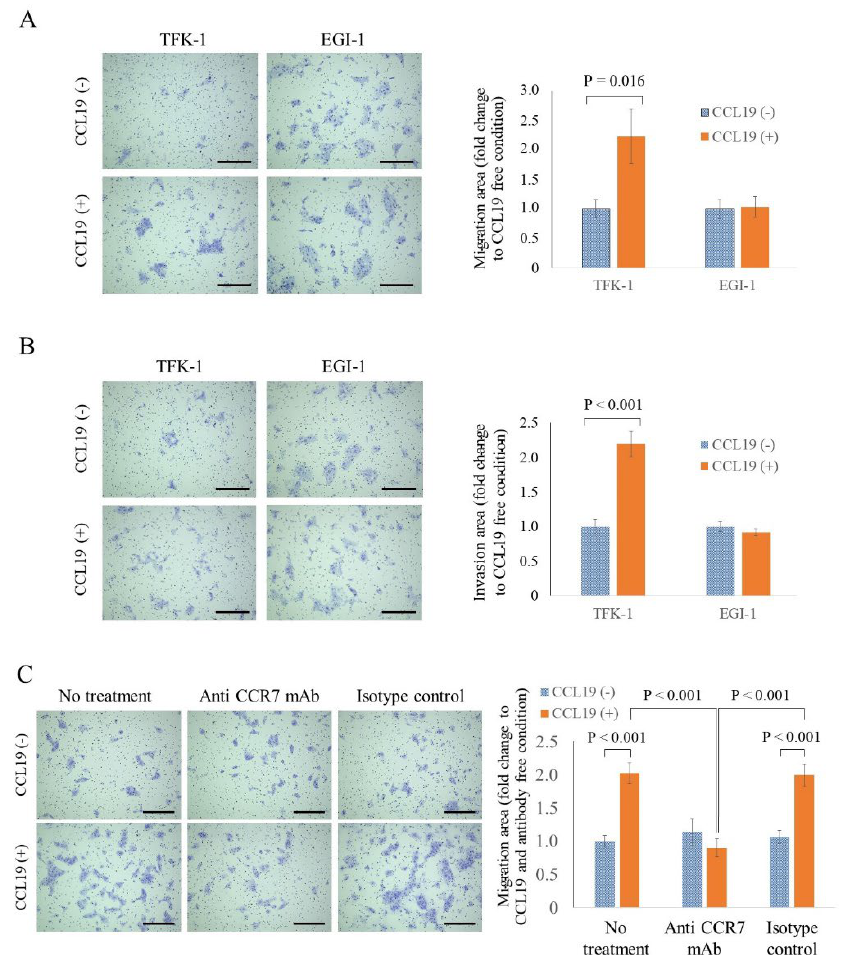
Figure 5. CCR7-dependent CCL19 promoted migration and invasion in cells. ( A ) The migration assay, used to determine the vertical migration ability for 48 h, showed that migration was significantly enhanced by treatment with CCL19 (100 ng/mL) in TFK-1 cells only ( p = 0.016, one-way ANOVA). ( B ) The invasion assay, used to determine the invasion ability for 48 h, showed that invasion was significantly enhanced by treatment with CCL19 (100 ng/mL) in TFK-1 cells only ( p < 0.001, one-way ANOVA). ( C ) A migration assay performed after preincubation of TFK-1 with 15 μg/mL anti-CCR7 antibodies for 6 h showed that anti-CCR7 antibody significantly suppressed CCL19-mediated migration ( p < 0.001, one-way ANOVA). Panels on the left in ( A – C ) show representative images of cells at the end-point, while those on the right show the quantification of the area covered by the assayed cells. Scale bar = 100 µ m. Each bar represents the mean ± SD of three independent experiments.